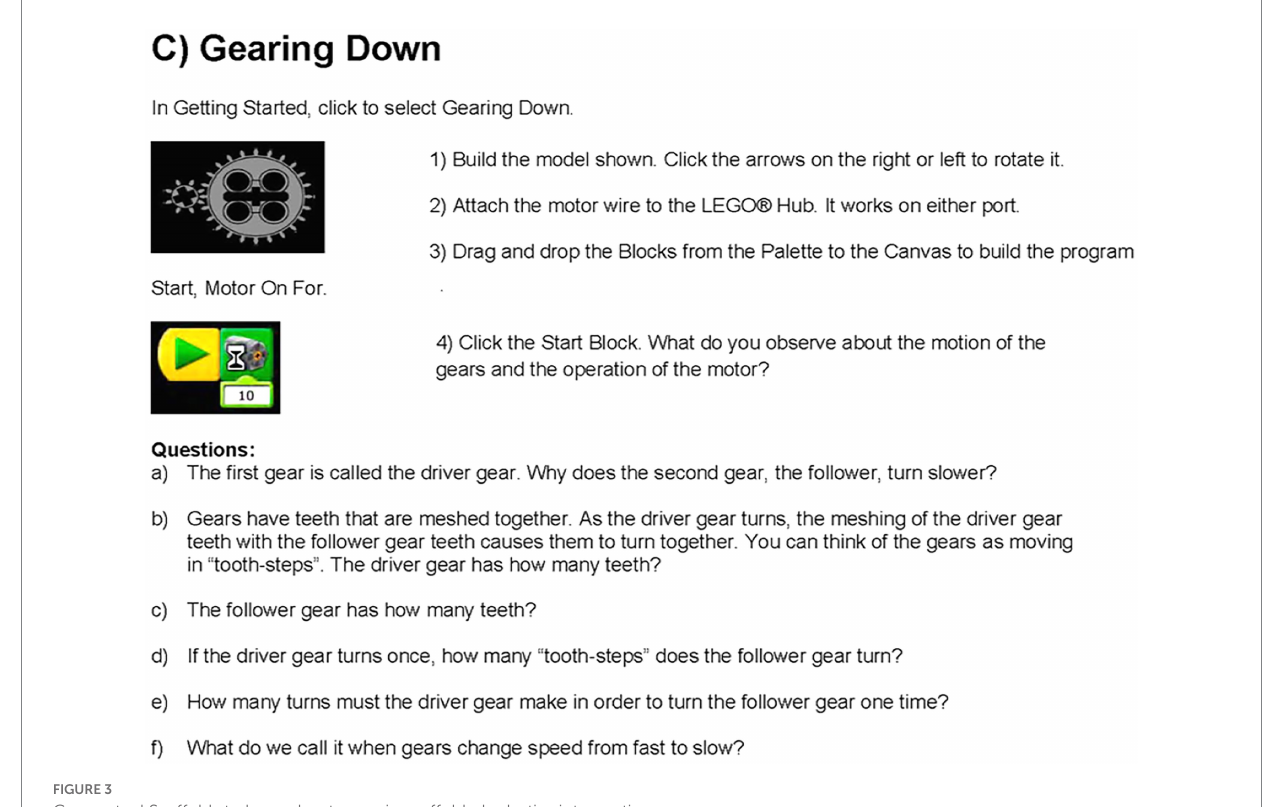
FIGURE 3 Conceptual Scaffolds to learn about gears in scaffolded robotics